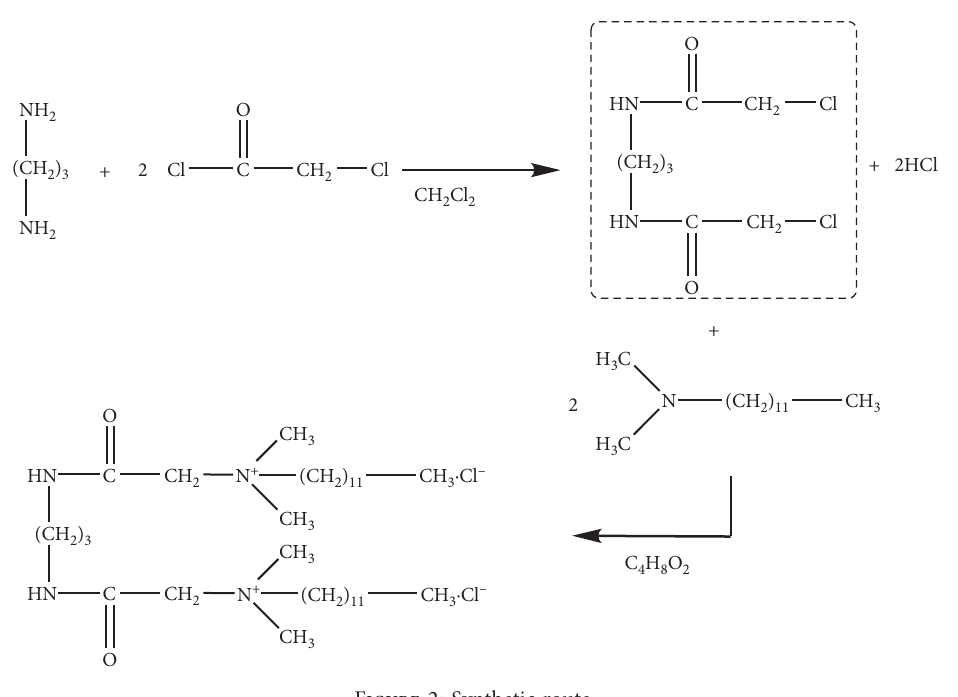
Figure 2: Synthetic route.